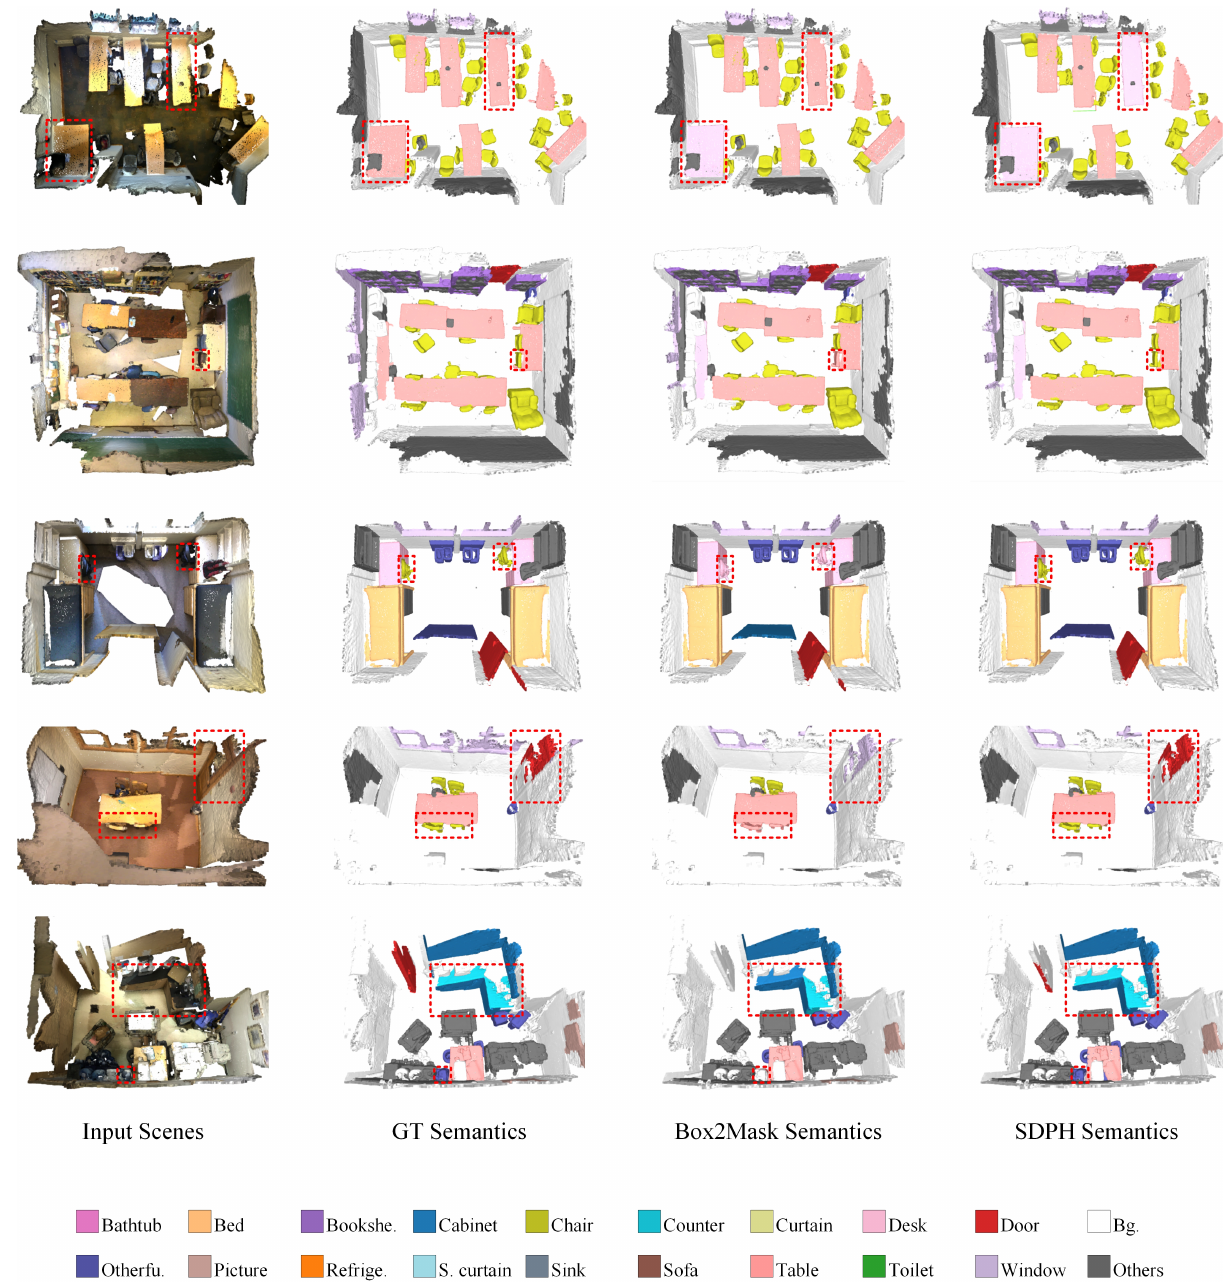
Figure 8. Qualitative comparison at a noise rate of 40% on ScanNet-v2. The legend is employed to distinguish among different semantic meanings, and the key differences are marked out with red dashed